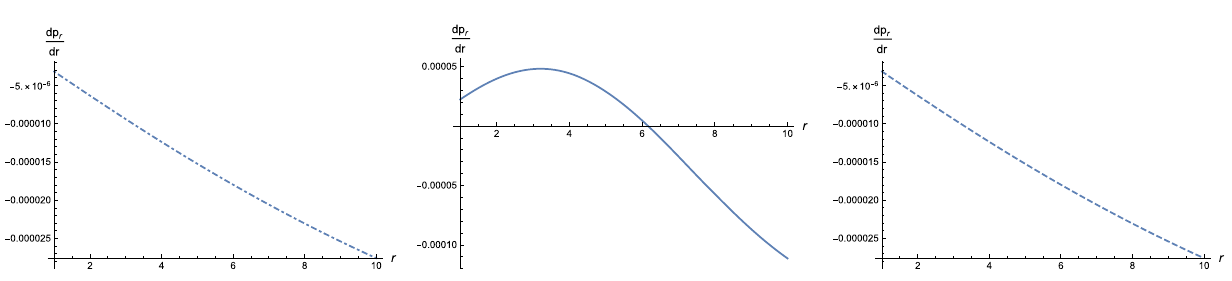
Fig. 4 Plots of d ρ with increasing radius of the strange star candidates Her X-1, SAX J 1808.4-3658, and 4U 1820-30; represented by (left to d r right) the first, second, and third graphs, respectively